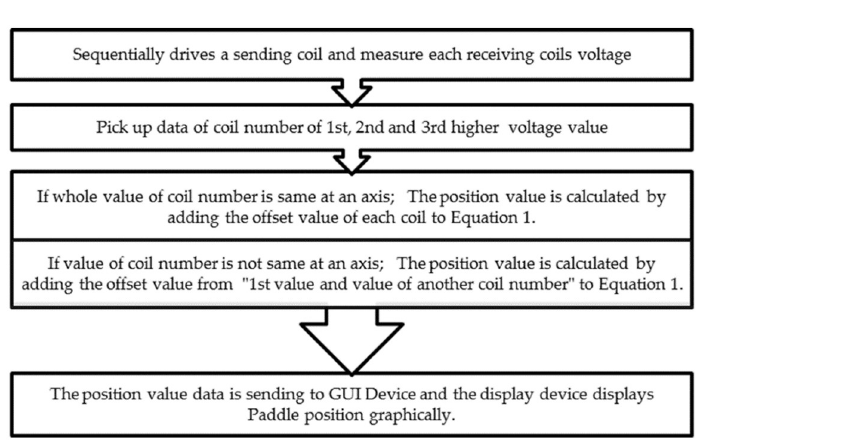
Fig 8. Schematic flowchart of position measuring algorithm in